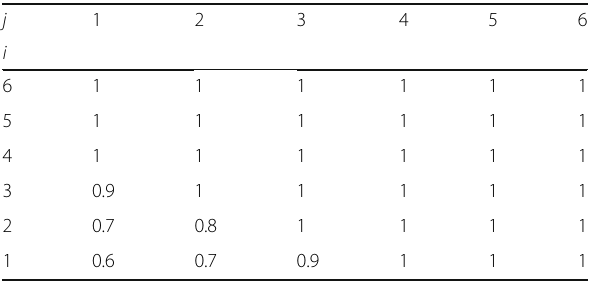
Table 8 The duty cycle used at each node